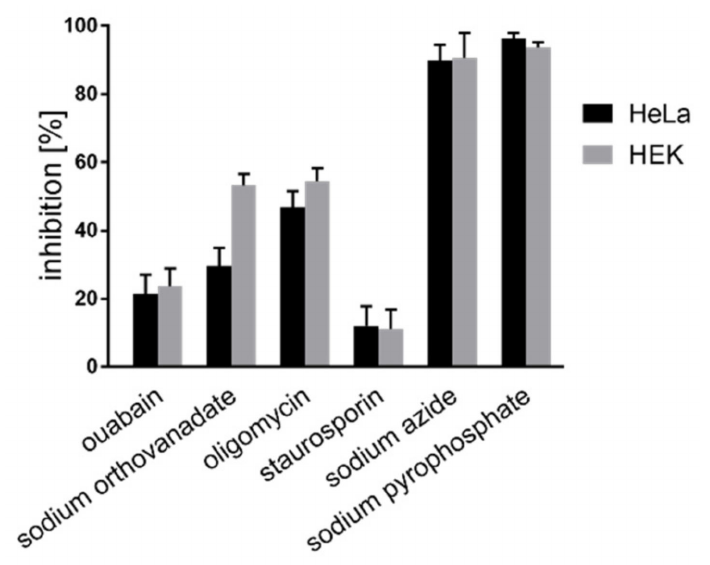
Figure 3. In vitro inhibition of Ap4 cleavage in HeLa and HEK cell lysates by various inhibitors monitored by fluorescence intensity